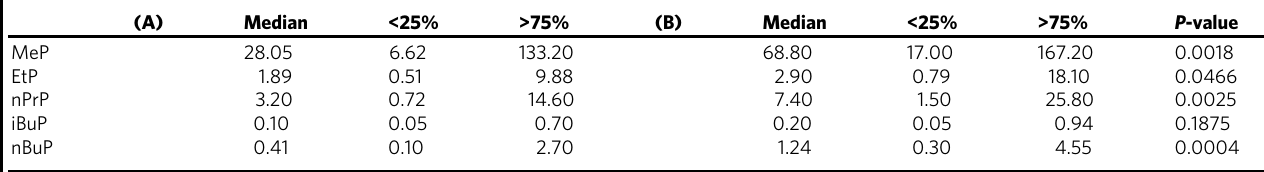
Table 1 Maternal urinary paraben concentrations [ µ g/l] in regard to cosmetic product application (A) usage of leave-on products during pregnancy without parabens ( n = 276) or (B) usage of leave-on products during pregnancy containing parabens ( n =